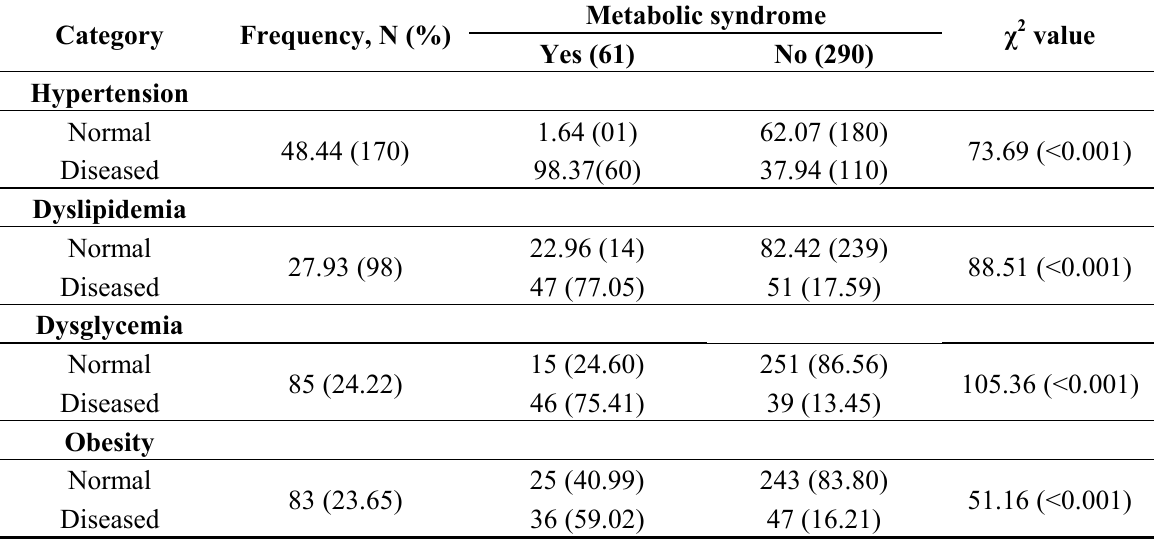
Table 3. Comparison of all the components of Metabolic Syndrome in the study subjects